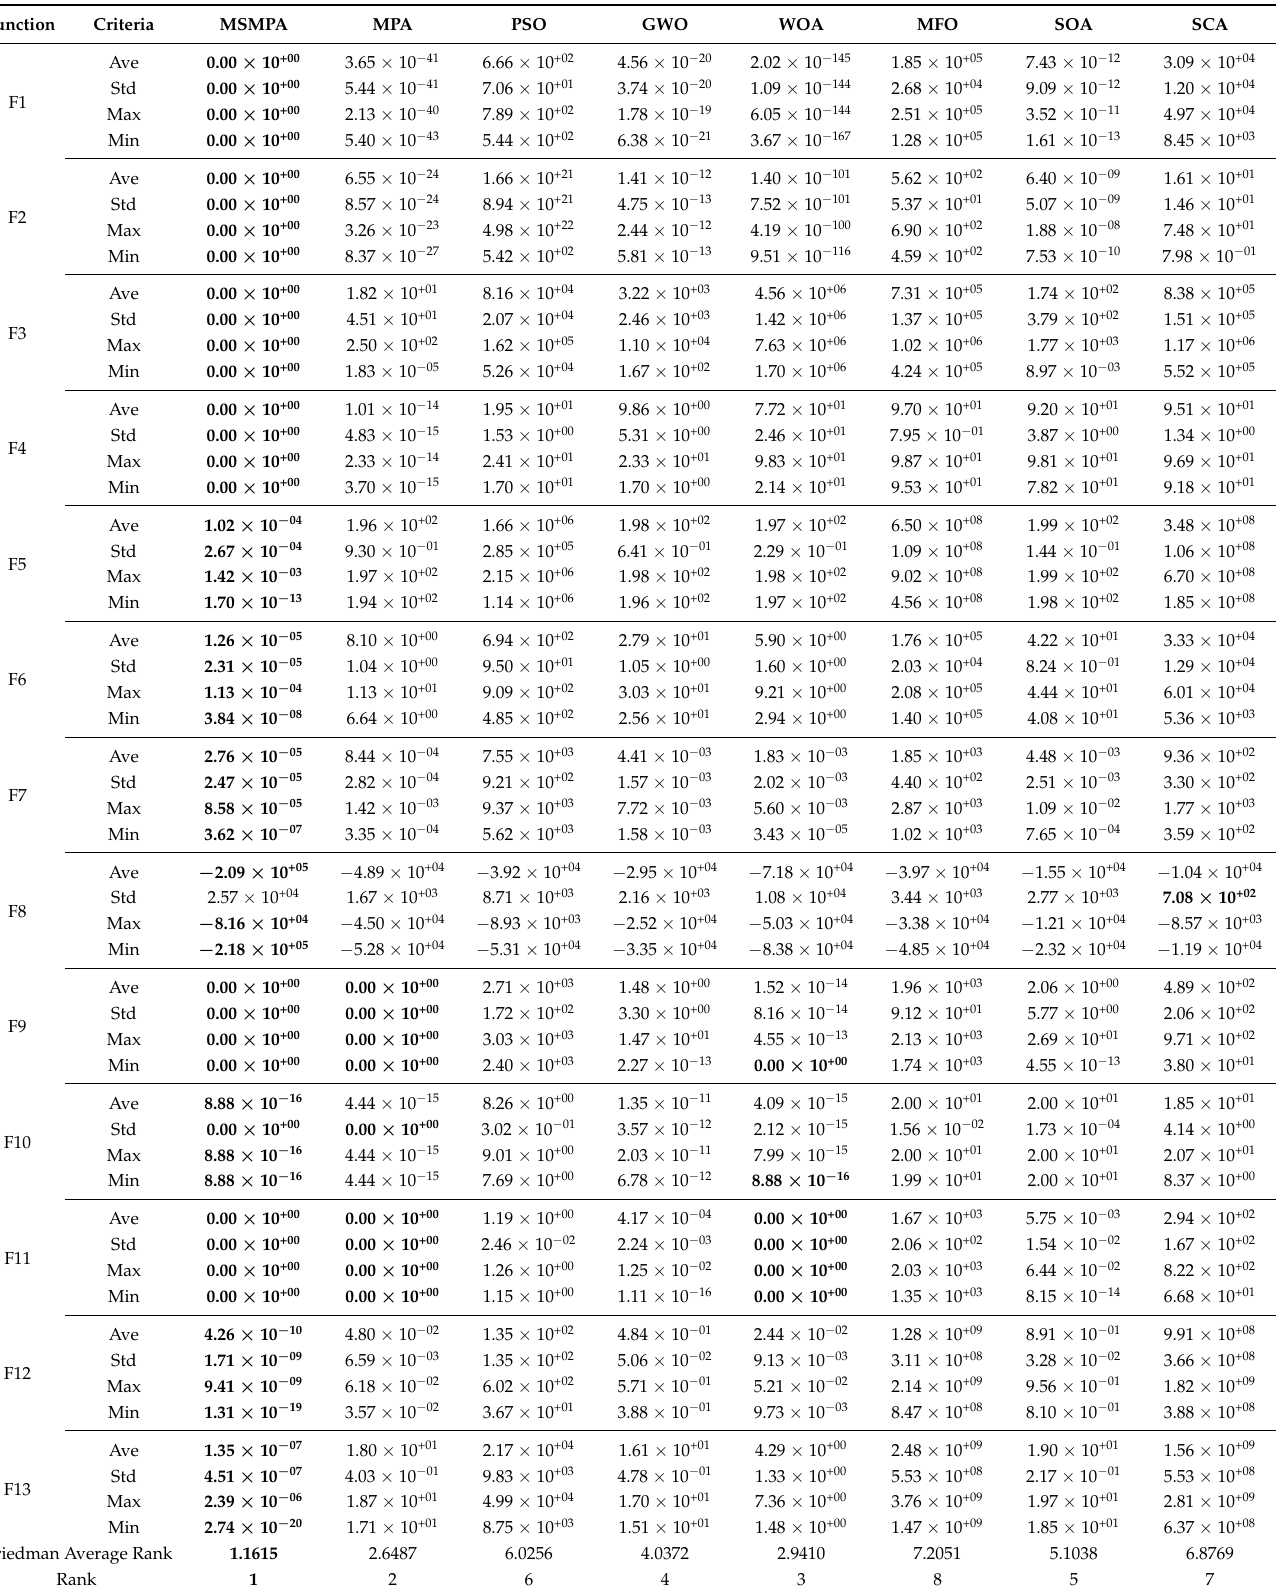
Table A5. Test results for each high-dimensional function in dimension